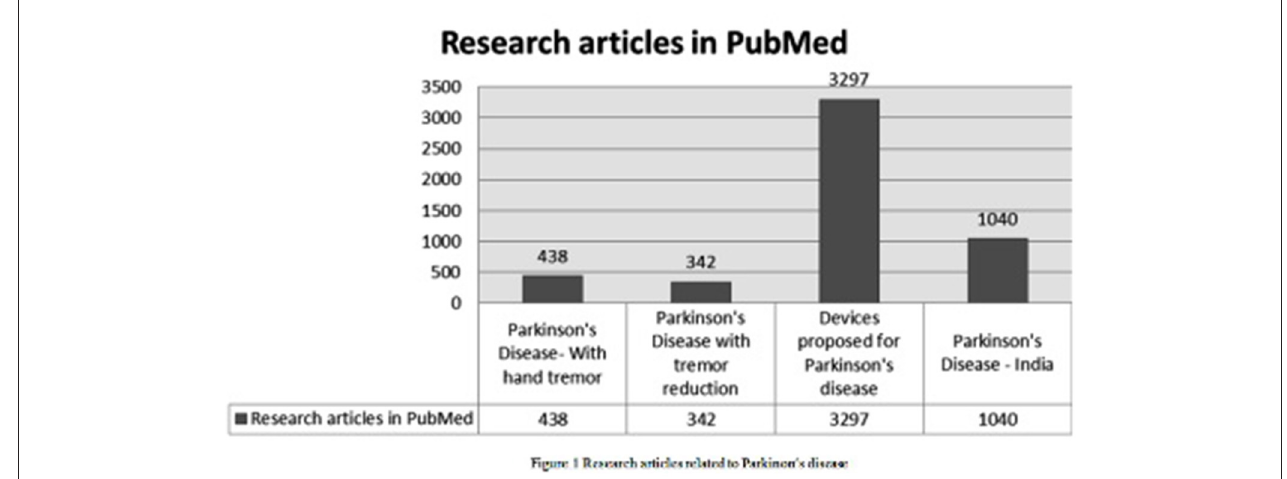
FIGURE 1 | Research articles related to Parkinson’s